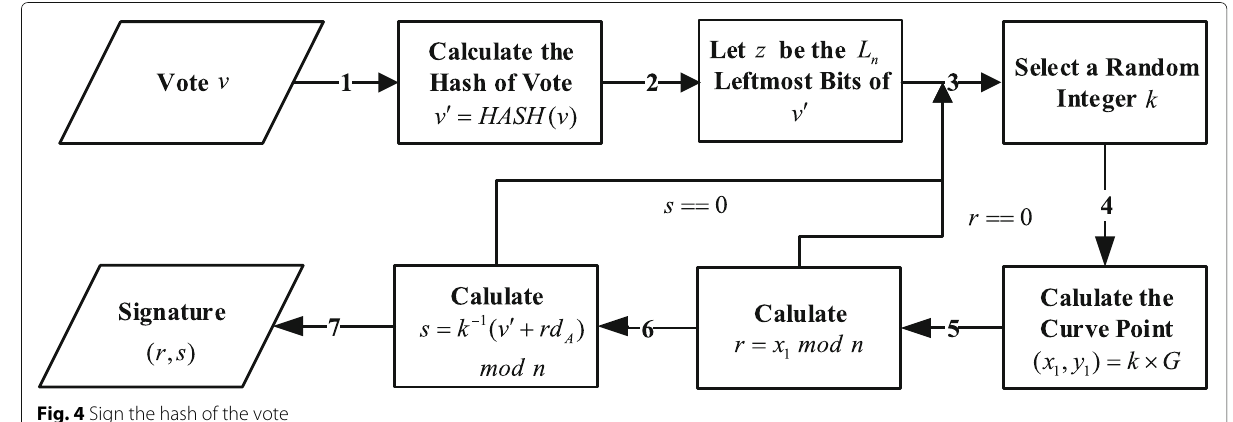
Fig. 4 Sign the hash of the vote